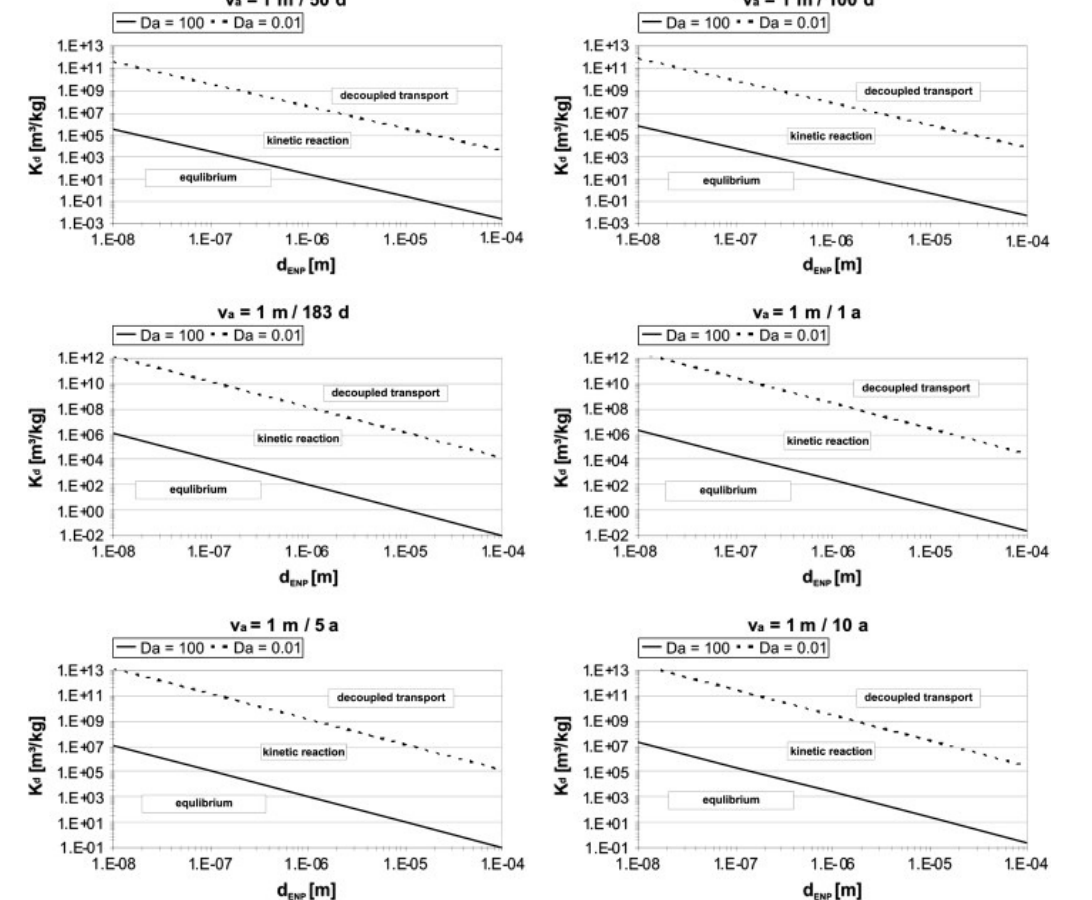
Figure 2. Simulation of diffusion-limited desorption using of pore water velocities (va) between 1m50d − 1 and 1–10myear − 1 (where “a” = annum). The solid line represents the Damköhler number of 100 (representing equilibrium transport above which the HOC will equi- librate between the CNM and soil matrix), the dashed line indicates a Damköhler number of 0.01 (decoupled transport below which HOC desorption will not occur within the time frame of transport). If Damköhler numbers are < 100 or > 0.01, the kinetics of sorption should be considered in transport models (Hofmann and von der Kammer, 2009). Re-printed with permission from Elsevier ©